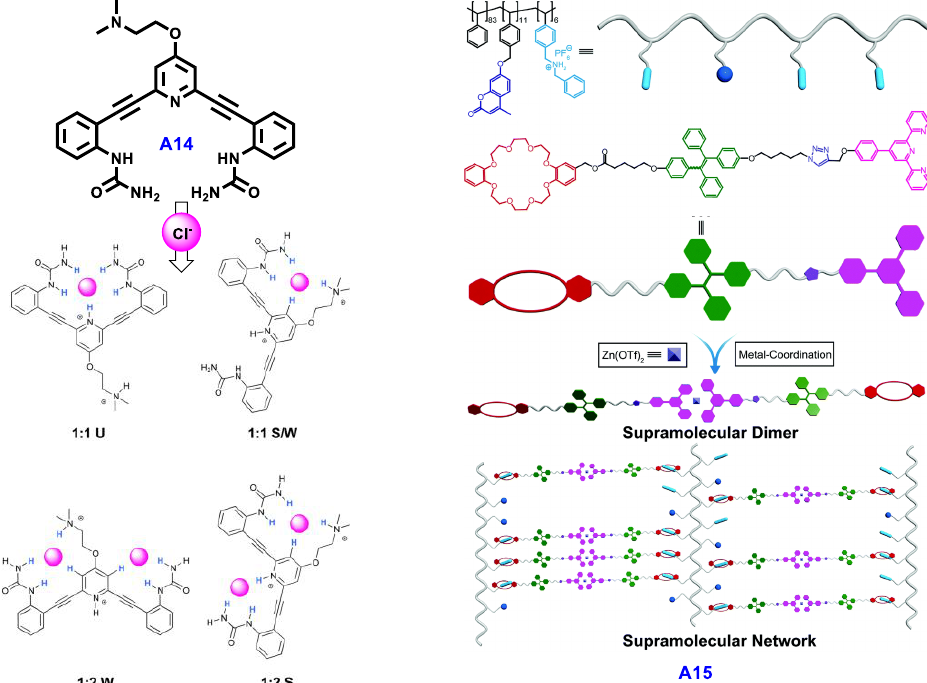
Table 2. Summary of optical properties and sensing performance of AIE-based chloride chemosensors A14 – A15